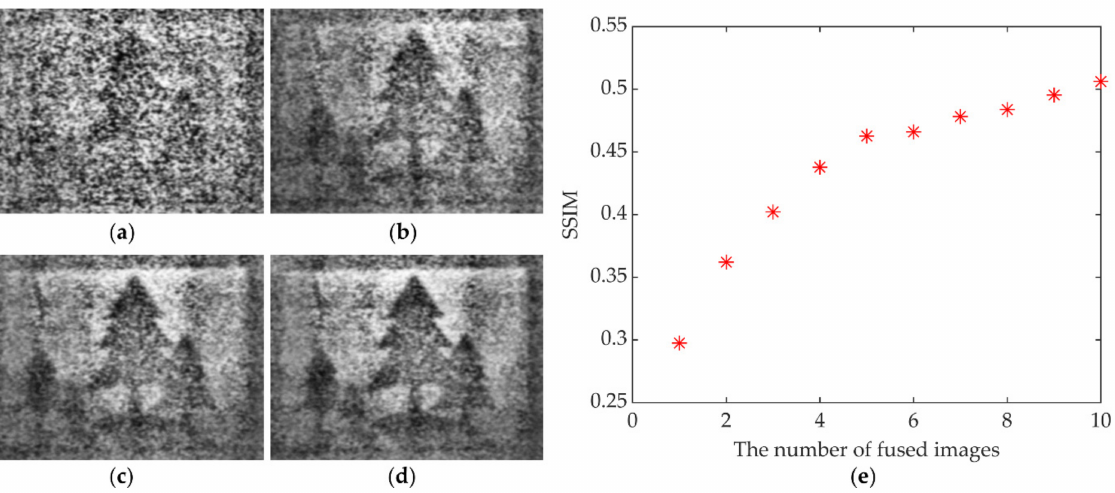
Figure 7. The comparison of the defogging results. ( a ) Fog removal of a single image (Figure 6a); ( b ) Fog removal of the synthetic image fused by four-view images (Figure 6a–d); ( c ) Fog removal of the synthetic image fused by seven-view images (Figure 6a–g); ( d ) Fog removal of the synthetic image fused by ten-view images (Figure 6a–j). ( e ) The dependence of SSIM on the number of fused